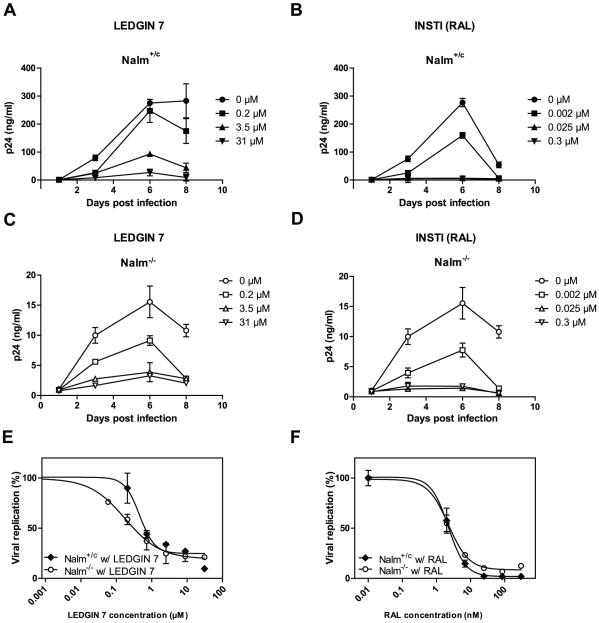
LEDGINs block residual HIV-1 replication in LEDGF/p75 KO cells.Nalm+/c and Nalm−/− cell lines were challenged with HIVIIIb in the presence of varying concentrations of HIV inhibitors. Supernatant was harvested for p24 ELISA. (A,C) LEDGIN 7 was added at different concentrations (0 µM, circles; 0.2 µM, squares; 3.5 µM, triangles or 31 µM, triangles pointing downwards). (B,D) Identical conditions were used as shown in (A,C), but the INSTI raltegravir (RAL) was added at different concentrations (0 µM, circles; 0.002 µM, squares; 0.025 µM, triangles or 0.3 µM, triangles pointing downwards). (A–D) Averages from duplicate experiments ± standard deviations are shown. (E) Dose-response curves in Nalm+/c and Nalm−/− cell lines were generated from p24 ELISA values obtained at day 6 for LEDGIN 7 concentrations of 0 µM, 0.06 µM, 0.2 µM, 0.7 µM, 3.5 µM, 8.9 µM, 31 µM. Data are fitted to a sigmoidal dose-response (variable slope) curve, from which IC50 values were calculated (Table S1). (F) In analogy with (E), p24 values obtained at day 6 for RAL were plotted to enable determination of IC50. RAL was used in concentrations of 0 µM, 0.002 µM, 0.007 µM, 0.02 µM, 0.08 µM and 0.3 µM.